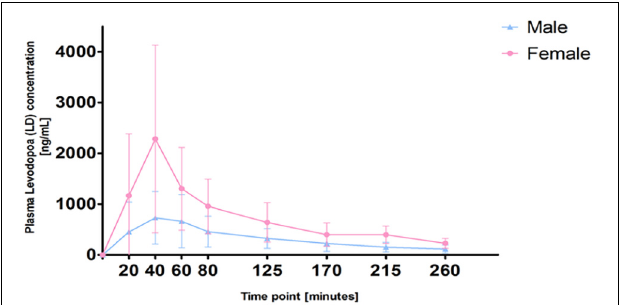
FIGURE 1 | Differences in plasma levodopa (LD) concentrations between men and women.